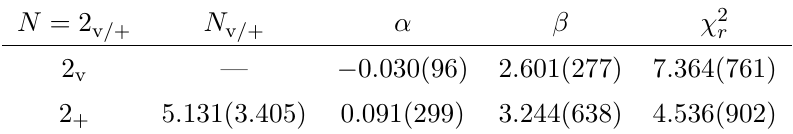
Table 3. Unpolarized nucleon valence and plus quark PDF parameters obtained from type- K fits to the real/imaginary component of M (cid:0) ν, z 2 (cid:1)